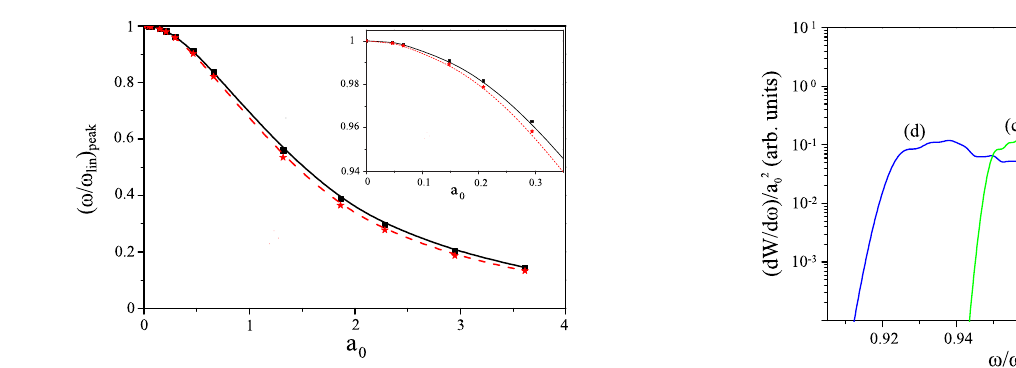
FIG. 7. Angle-integrated spectrum in the case of the experi- ment PlasmonX at SPARC-LAB for different values of a 0 , obtained by compressing the laser pulse. (cid:1) ¼ 300 , (cid:9) acc ¼ 0 : 5 mrad , E ¼ 5 J , (a) a 0 ¼ 0 : 1 ( (cid:3) (cid:6) ¼ 6 ps ), (b) a 0 ¼ 0 : 15 L ( (cid:3) (cid:6) ¼ 3 ps ), (c) a 0 ¼ 0 : 25 ( (cid:3) (cid:6) ¼ 1 ps ), and (d) a 0 ¼ 0 : 35 ( (cid:3) (cid:6) ¼ 0 : 5 ps